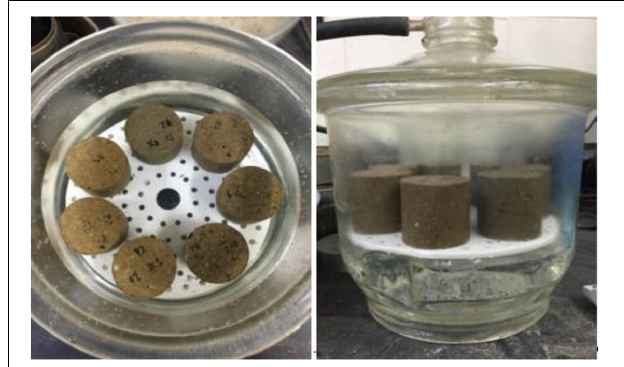
FIGURE 1 | Vacuum saturation of cement stabilized